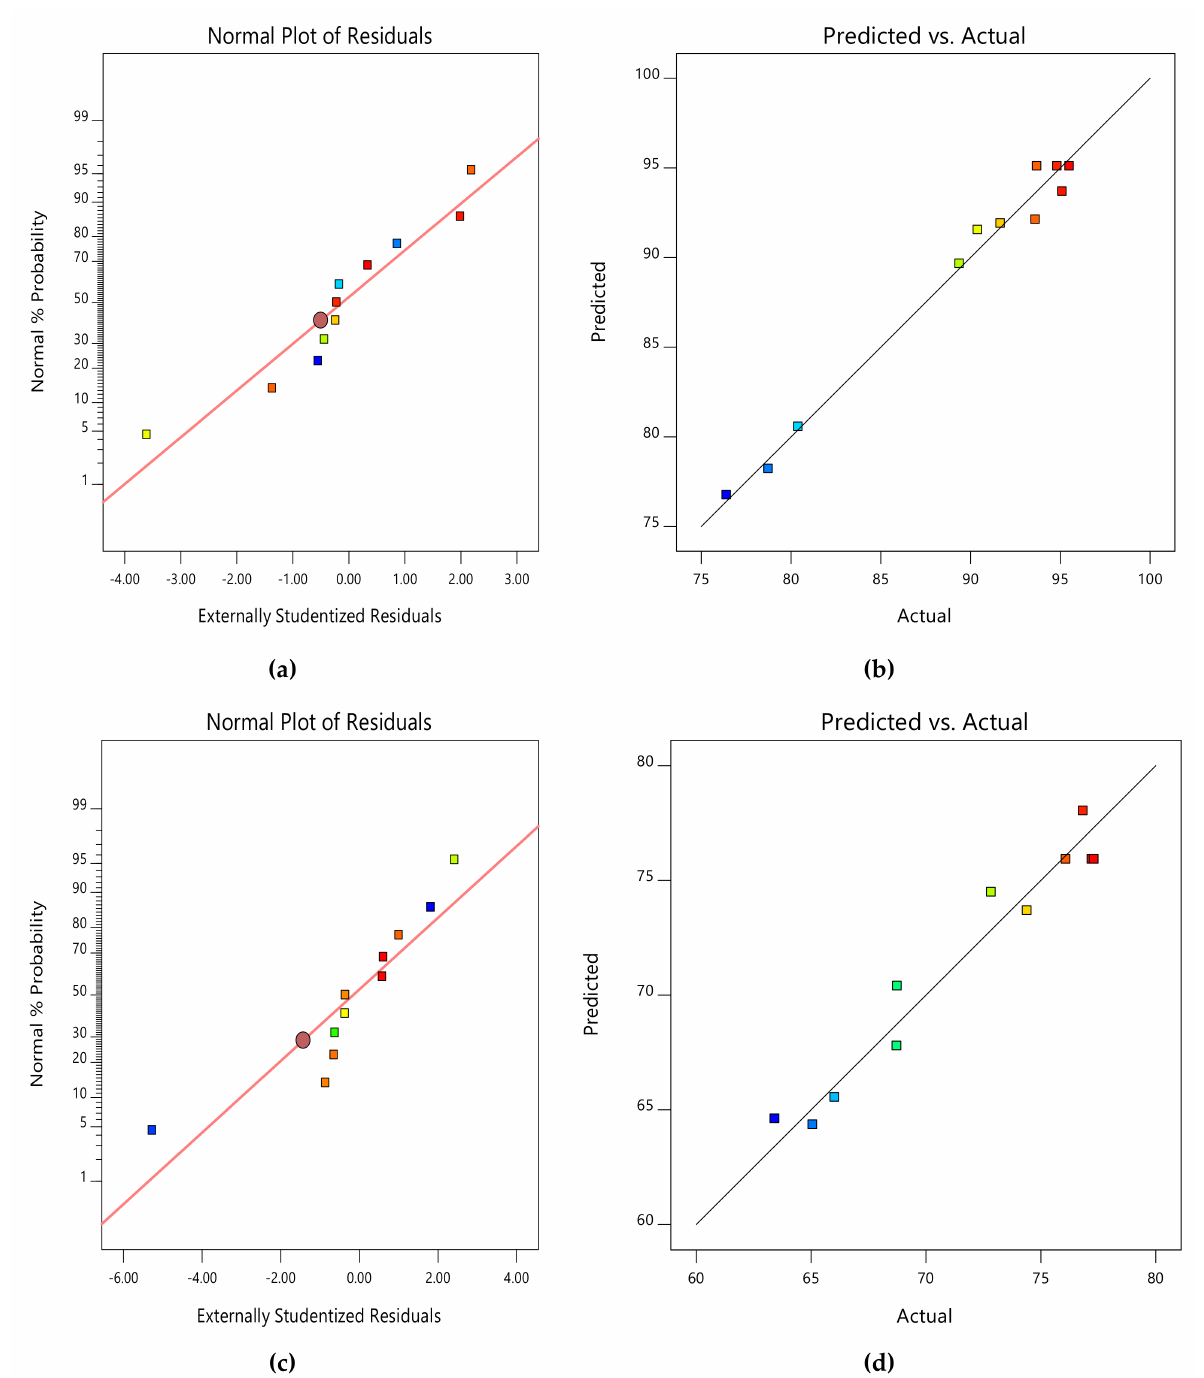
Figure 9. Normal plots of residuals and predicted versus actual plots of SB-CMAS bioreactor for COD ( a , b ) and NH 4+ − N ( c , d )